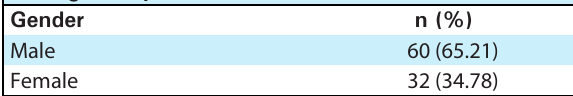
Table 2. Gender wise distribution of onychomycosis